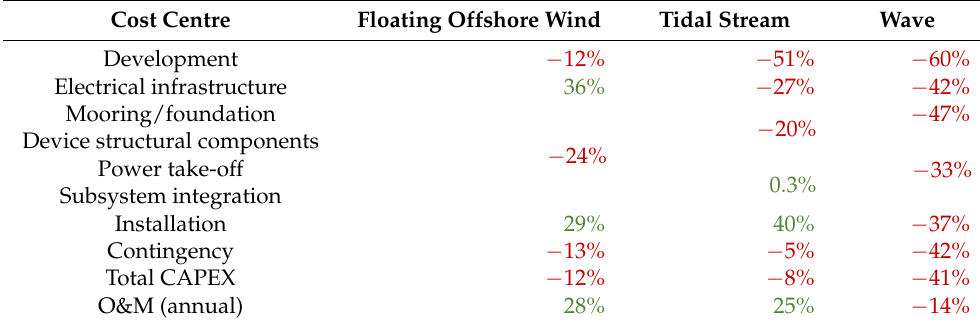
Table 12. Percentage change between early-stage cost results (central LR) and BVG associates ‘typical costs’ for small-scale projects in 2020. Negative figures indicate where BVGA 2020 figures are higher than the early-stage thresholds